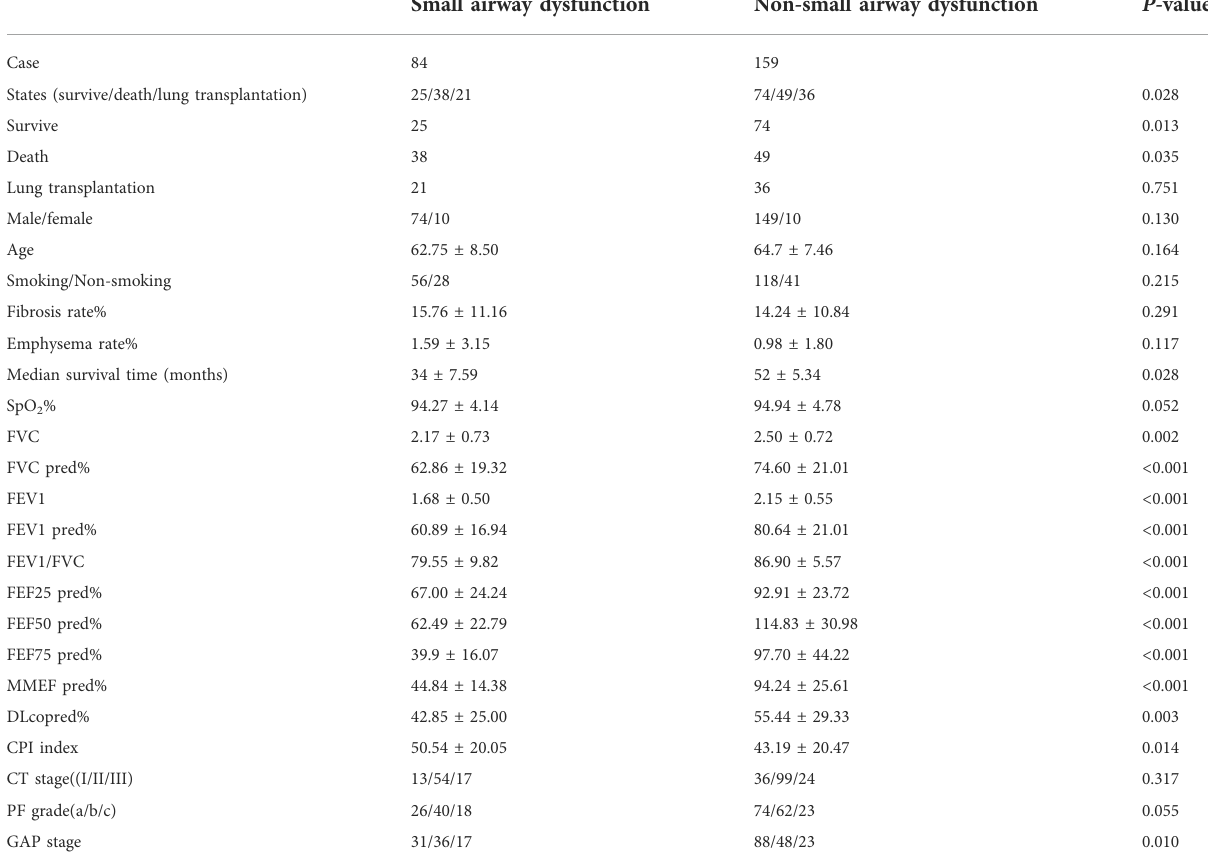
TABLE 1 Comparison of case